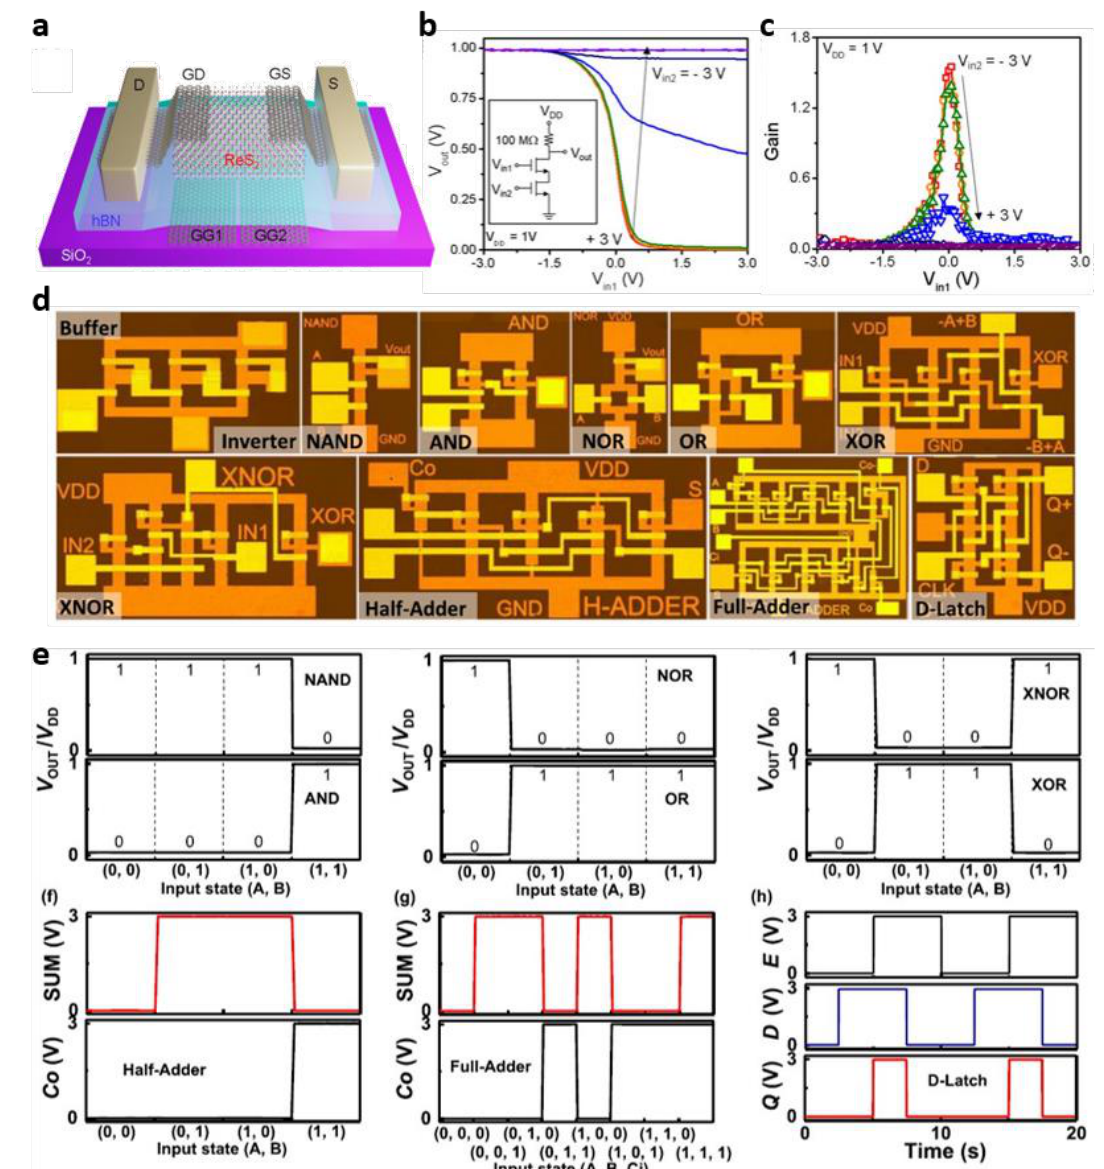
Figure 5. TMD-based digital thin-film circuits. ( a ) Structural schematic diagram of ReS 2 TFT with graphene split gates. ( b ) Input/output characteristics and ( c ) corresponding gain of a logic circuit consisting of a resistor and a ReS 2 FET with two graphene split gates (adapted from [ 73 ] with permission from Springer Nature). ( d ) Various digital circuits, such as buffers and inverters, based on MoS 2 TFT and ( e ) input/output characteristics corresponding to each (adapted from [ 74 ] with permission from the American Chemical Society).